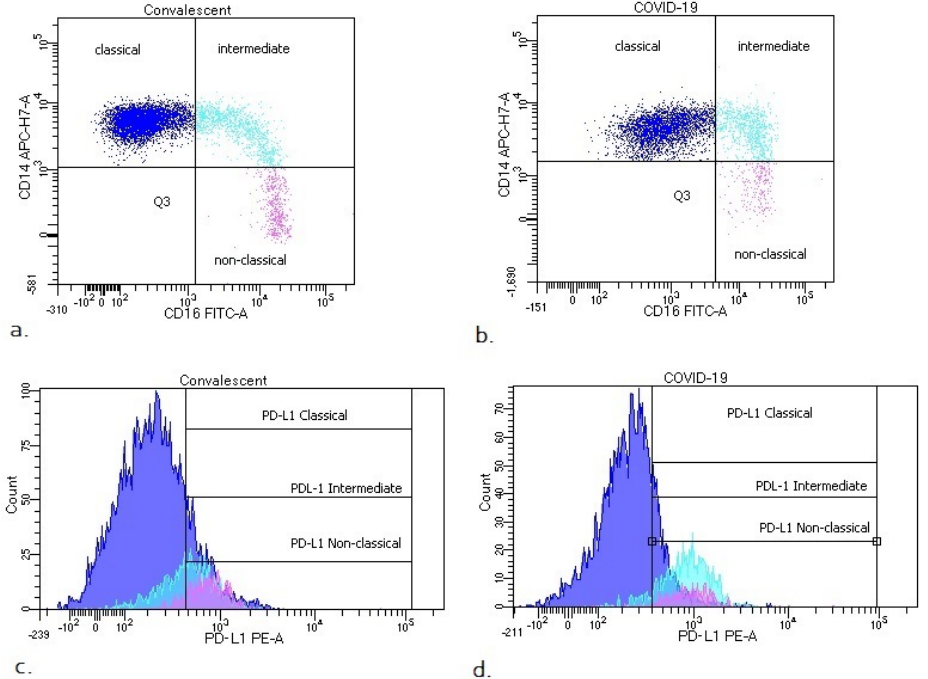
Figure 4. Representative dot plots with monocyte subsets classical, intermediate and non-classical ( a , b ) and histograms with monocyte subsets with PD-L1 expression ( c , d ) in COVID-19 and convalescent patients. Table 3. Median proportion of three types of monocytes and monocyte subsets with PD-L1 expres- sion between patients with COVID-19 and convalescent COVID-19 patients. Data expressed as me-